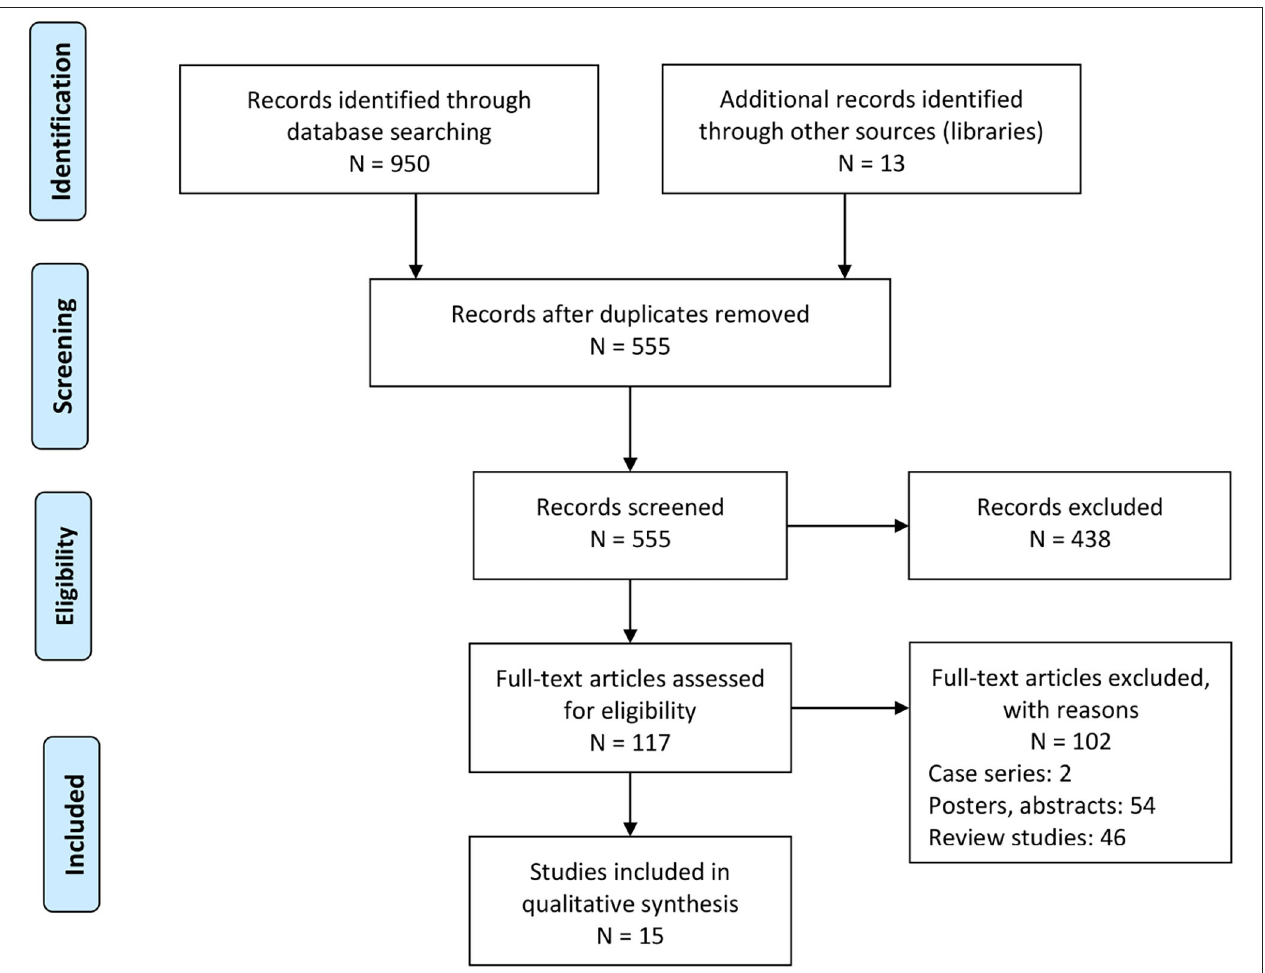
FIGURE 1 | PRISMA